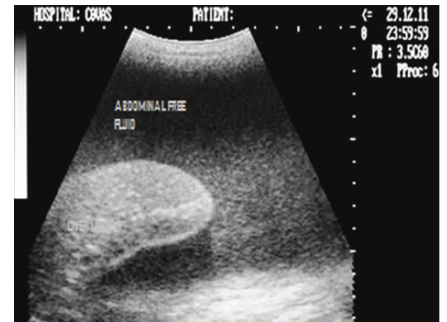
Figure 23: Two-dimensional ultrasonographic appearance of liver in sagittal scan depicting hyperechoic parenchyma with rounding of liver lobe surrounded with textured fluid in a 6-year-old male Labrador Retriever a ff ected with infectious